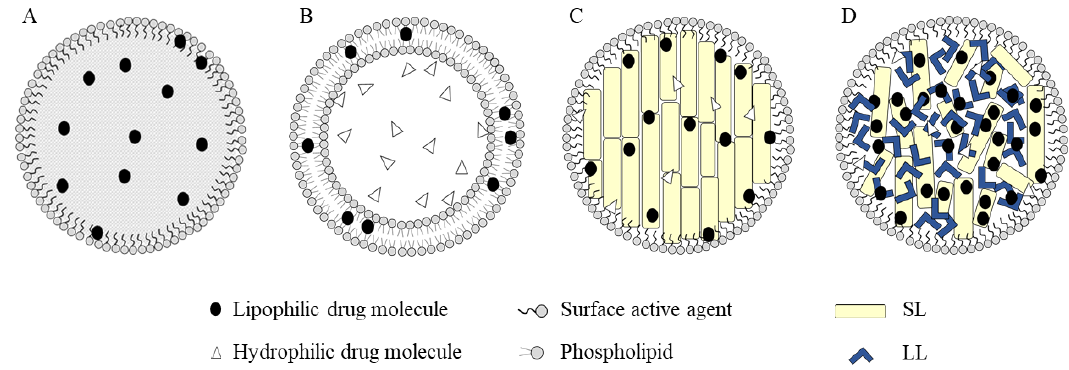
Figure 1. Different types of lipid-based nanoparticles. ( A ) Nanoemulsions; ( B ) liposomes; ( C ) solid lipid nanoparticles (SLNs); and ( D ) nanostructured lipid carriers (NLCs).